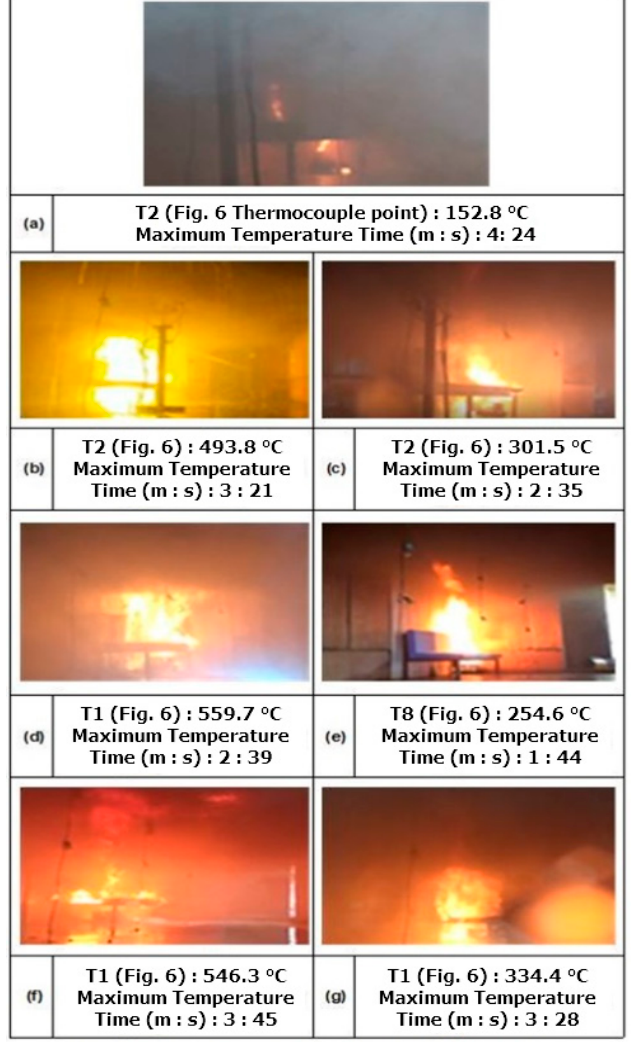
Figure 8. Scene when the maximum temperature is reached in the fire test according to the igni- tion source application plan. source application